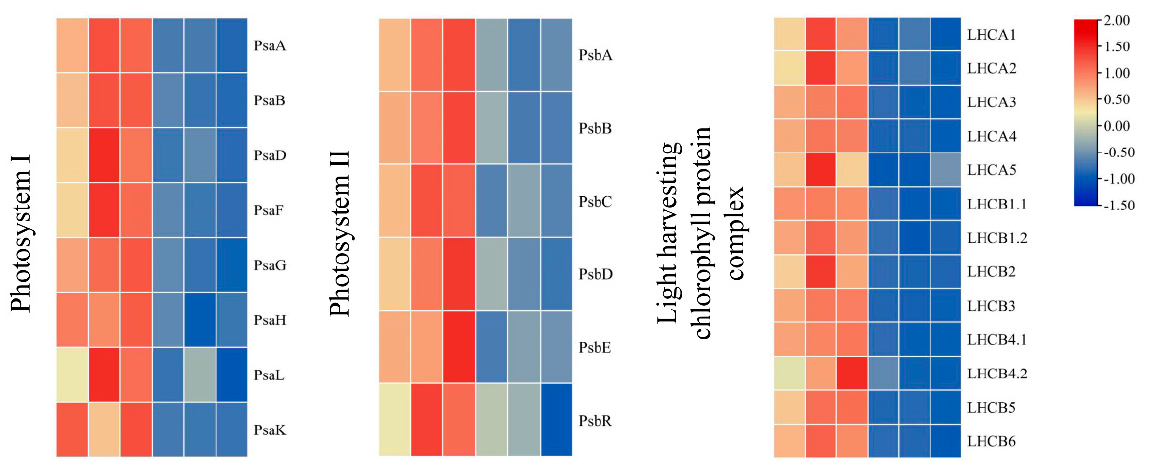
Up-regulated proteins were primarily related to oxidoreductase activity and binding categories, particularly DNA binding, RNA binding, and lipid binding (Figure 7). Heat shock proteins (HSPs) and ribosomal proteins are the two major components of these